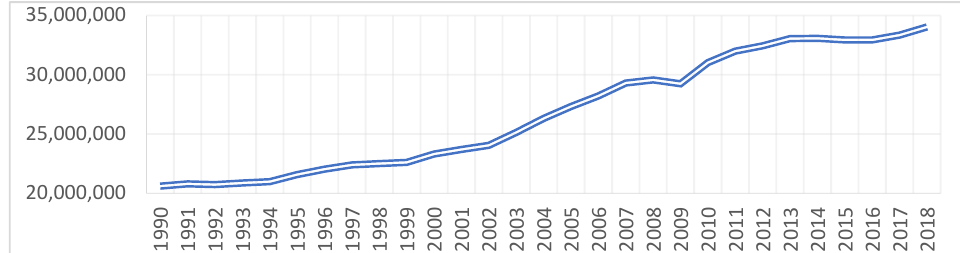
Figure 1. CO 2 emissions world-wide (metric tons). Source: developed by the authors using data from World Bank indicators.